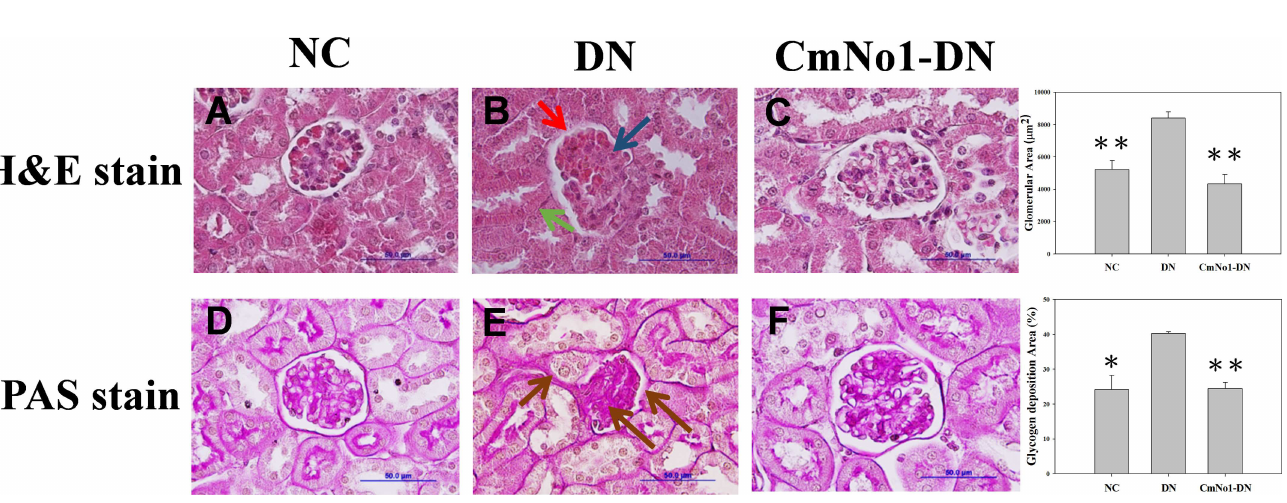
PLOS ONE | DOI:10.1371/journal.pone.0166342 November10,